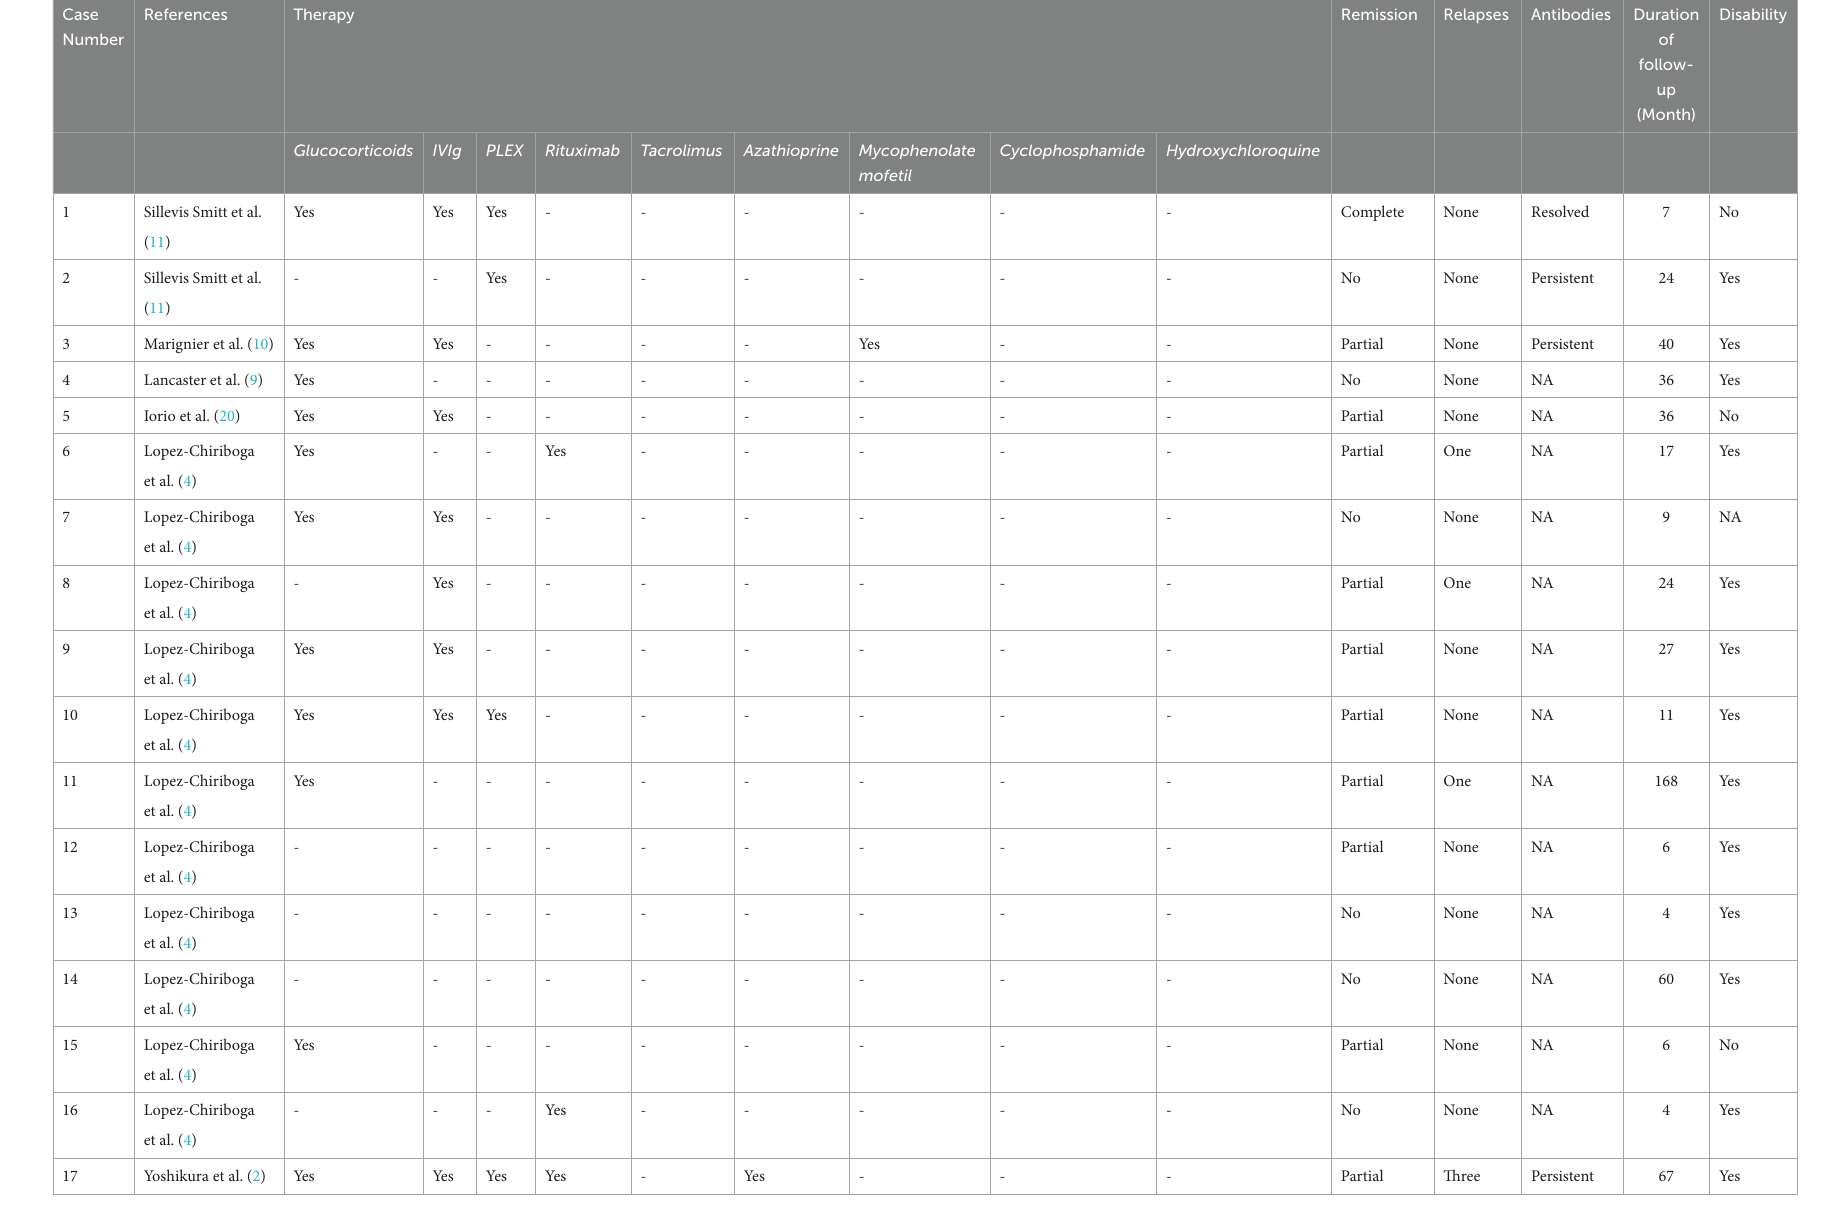
TABLE 4 Summary of management of all reported cases of 36 patients with anti-mGluR1